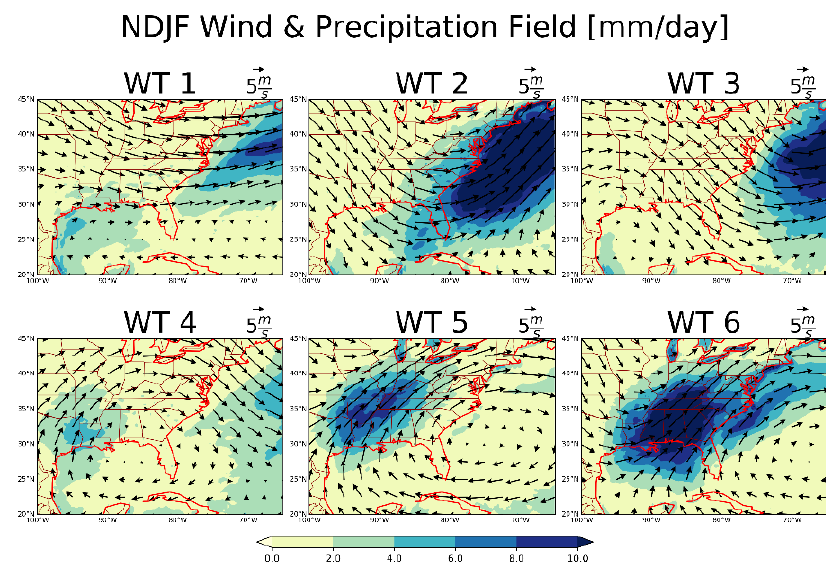
Figure 3. The average precipitation (shade, mm/day) and 850 hPa winds (arrows) of the six WTs. WTs 1 – 6 can be briefly described as Shallow Trough (ST), East Coast Trough (ECT), Off East Coast Trough (OECT), Mississippi River Valley Ridge (MRVR), Western Plains Trough (WPT) and Plains Trough (PT), respectively. Table 1. Six weather types in the winter and their 850 hPa flow